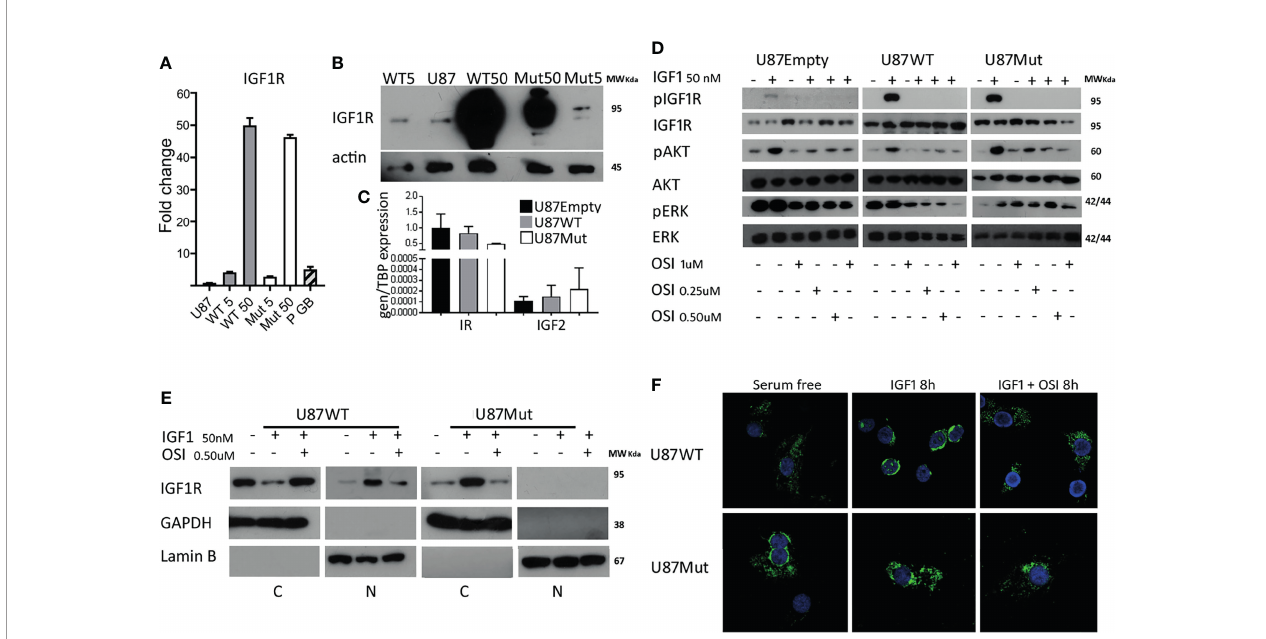
FIGURE 1 | Characterization of wild type and mutant IGF1R U87 clones. (A) IGF1R mRNA expression in clones generated after the transfection of wild-type (WT) or mutant (Mut) IGF1R in U87 cells. Values are presented as fold change compared to U87 cells. (B) Representative western blotting for IGF1R in protein extracts from WT and Mut clones. (C) The IR and IGF2 mRNA expression in U87Empty, U87WT 5, and U87Mut 5 cells was calculated using relative quantitation method. Values are presented relative to TBP mRNA expression. (D) Western blotting of U87Empty, U87WT 5, and U87Mut 5 cells after 10 min of 50-nM IGF1 stimulation and/or pre-incubation (1 h) with IGF1R/IR inhibitor OSI906 (OSI) in different concentrations (0.25, 0.5, and 1 m M). The membranes were blotted with antiphospho-IGF1R (pIGF1R), antiphospho-AKT (pAKT), or antiphospho-ERK (pERK). The blots were stripped and reprobed with antitotal-IGF1R (IGF1R), antitotal-AKT (AKT), or antitotal-ERK (ERK). (E) Subcellular fractionation of U87WT 5 and U87Mut 5 cells after 8 h of 50-nM IGF1 stimulation with or without pre-incubation (1 h) with 0.5 m M OSI906 (OSI) followed by Western blotting. GAPDH and Lamin B were used as markers of non-nuclear and nuclear fractions, respectively. (F) Confocal immuno fl uorescence microscopy of U87WT 5 and U87Mut 5 cells after 8 h of 50-nM IGF1 stimulation with or without pre-incubation (1 h) with 0.5 m M OSI906 (OSI). Representative pictures; IGF1R in green (pEGFP vector) and nucleus in blue (Hoechst